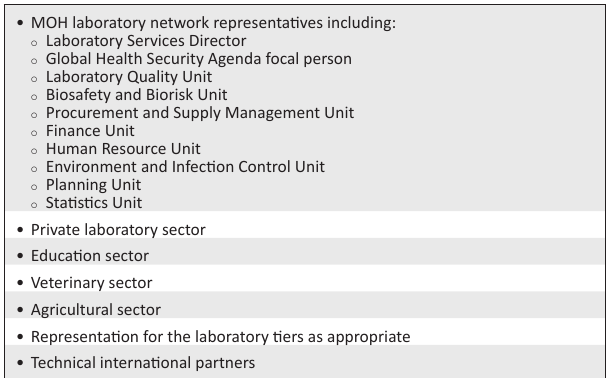
FIGURE 3: Summary of country results using percentages and